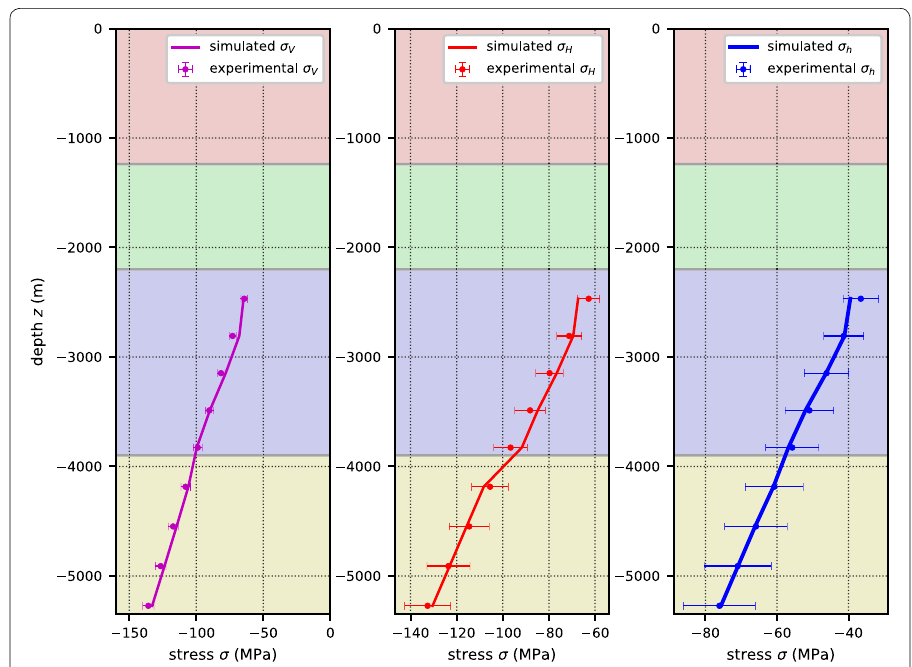
Fig. 5 Fitting principal stress components–depth profiles: (left) vertical σ v and (middle) horizontal minimum σ h and (right) maximum σ H stress–depth profiles obtained at the middle of the Rittershoffen mesh